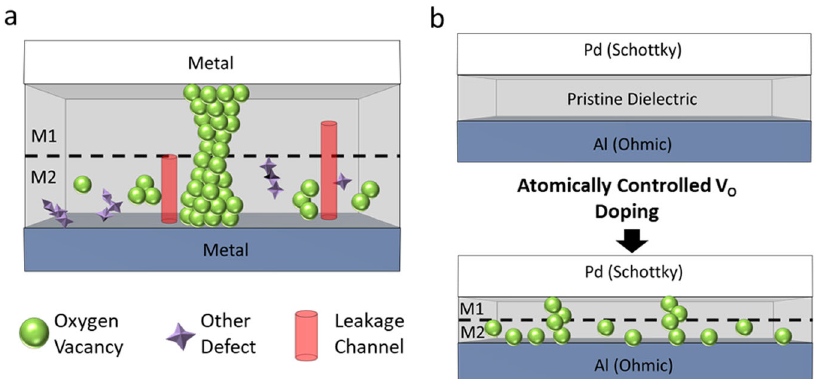
Fig. 1 Concept of atomically tuned memristors. a Hypothetical distribution of oxygen vacancies (V O ) and other defects in the M1(oxide)/M2(defective oxide) stack of a memristor formed using conventional physical vapor deposition or atomic layer deposition, and b the atomically controlled oxygen vacancy doping from a pristine insulating oxide to allow tunable memristive switching in ultrathin memristors.